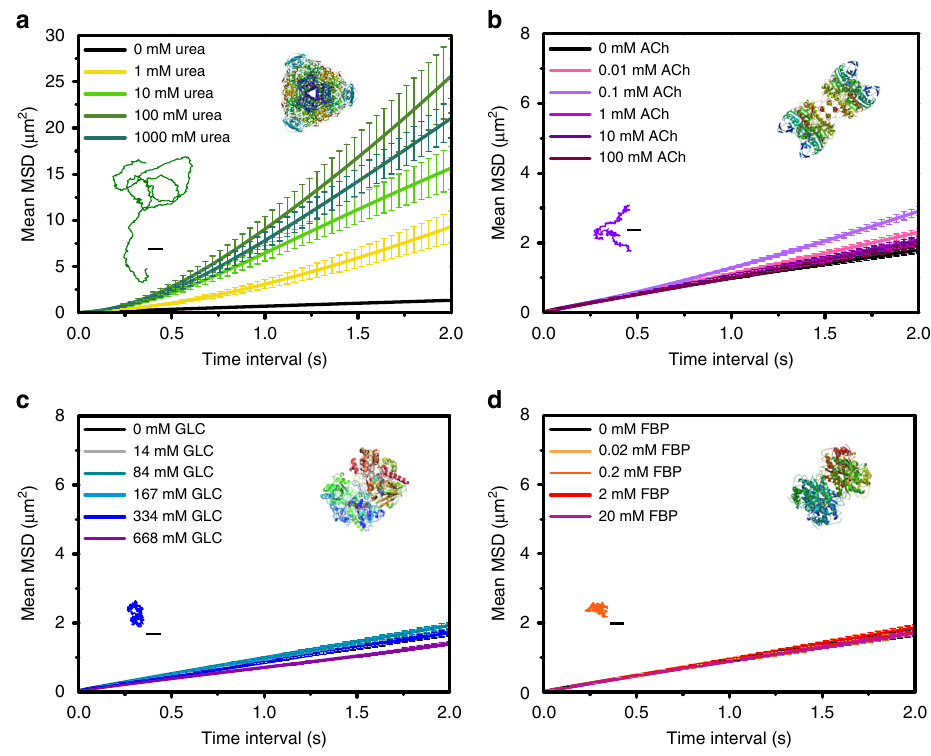
Fig. 2 Motion dynamics UR, AChE, GOx, and ALS micromotors. Average MSD over time for different substrate concentrations: a UR-HSMM, b AChE- HSMM, c GOx-HSMM, and d ALS-HSMM. Inset: representative trajectories for a UR-HSMM with 100 mM urea, b AChE-HSMM with 0.1 mM acetylcholine (ACh), c GOx-HSMM with 334 mM glucose (GLC), and d ALS-HSMM with 0.02 mM fructose 1,6-bisphosphate (FBP) (scale bars: 2.5 μ m). Enzyme structures are extracted from RCSB PDB (see Supplementary Note 3). Results are shown as the mean ± standard error of the mean (s.e.m.). Twenty particles were analyzed per condition. Source data are provided as a Source Data fi